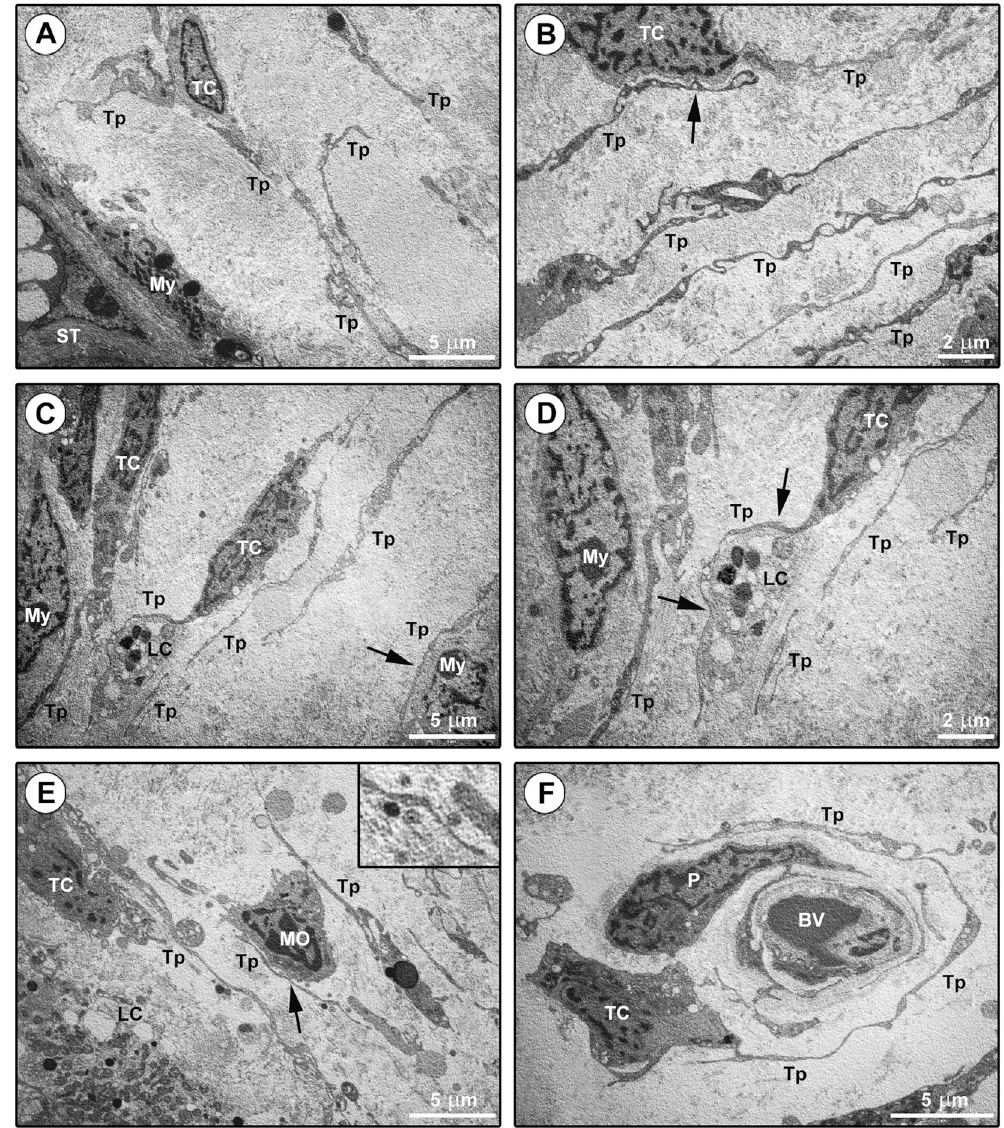
Figure 6. Ultrastructural investigation of the human testis stromal compartment. ( A–F ) Representative transmission electron microscopy photomicrographs of testicular ultrathin sections stained with UranyLess and bismuth subnitrate solutions. Telocytes (TC) are ultrastructurally characterized by (i) a spindle-shaped, oval or piriform cell body mostly occupied by a relatively large euchromatic nucleus surrounded by a scarce cytoplasm, and (ii) the presence of telopodes (Tp), long cytoplasmic processes with a narrow emergence from the cell body and a moniliform silhouette characterized by the alternation of thin segments (podomers) and expanded parts (podoms). ( A ) Telocytes with long telopodes are present in the outer layer of the peritubular connective tissue, while myoid cells/myofibroblasts (My) are located in the inner layer in close contact with the seminiferous tubule (ST) basement membrane. ( B ) Telopodes are often convoluted and form a reticular network in the intertubular stroma. Note an intercellular contact (arrow in B ) between the cell body of a telocyte and the telopode of another telocyte. ( C–E ) The telopodes of telocytes establish close contacts with peritubular myoid cells/myofibroblasts (arrow in C ), intertubular steroidogenic Leydig cells (LC) (arrows in D ) and blood-derived mononuclear cells (MO) (arrow in E ). Numerous extracellular vesicles are present nearby telopodes ( E , shown at higher magnification in the inset). ( F ) The long and convoluted telopode of a telocyte intimately surround the abluminal side of the basement membrane of a blood vessel (BV). Note a pericyte (P) embedded in the vessel basement membrane. Scale bar: 5 µ m ( A,C,E,F ), 2 µ m ( B,D